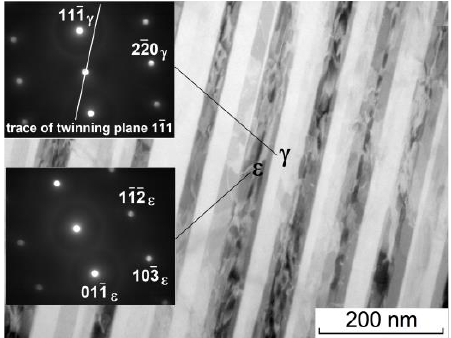
Figure 4. A bright-field TEM-micrograph of the Cr-Mn-N steel fine structure after the tensile test at − 196 ◦ C and the electron nanodiffraction patterns of the ε -martensite (z = [311]) and austenite (z = [112] γ ) plates.